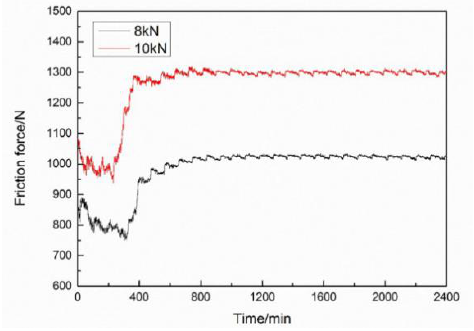
Figure 10. Friction forces of the tribo-pairs under varied loads.